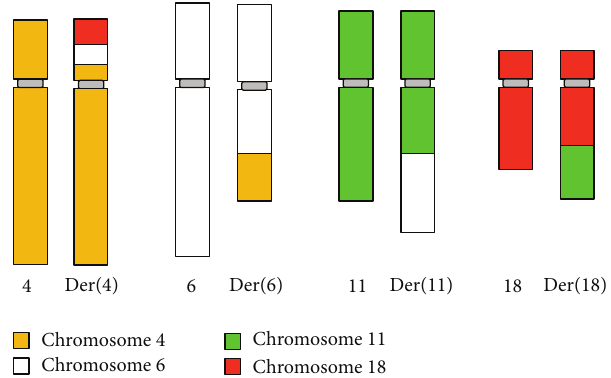
Figure 4: Cartoon summary of the BCCR carried by the proband’s mother and